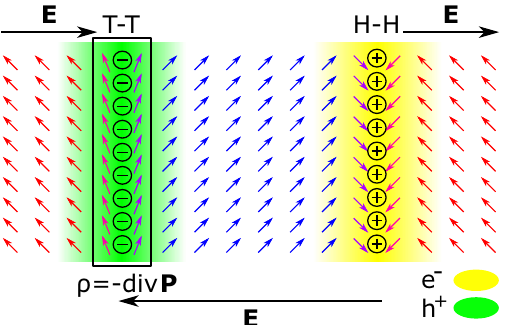
Fig. 1 Ferroelectric domain walls. Illustration of a ferroelectric material containing charged domain walls (DWs). Coloured arrows denote the polarization orientations. DWs are the interfaces between domains with different polarization orientations. There are head-to-head (H-H) and tail-to-tail (T-T) charged DWs depending of the polarization orientation with respect to the DW plane. The polarization changes at these DWs form bound charge (labelled by plus and minus). The direction of the electric fi eld induced by the bound charge is given with the black arrow. The electric fi eld localizes free charge carriers on the DWs (green — holes, yellow — electrons). In the 39° (11 1 ) DWs considered here, the angle between the polarizations in neighbouring domains is 39°, and the DWs are in the (11 1 ) plane.